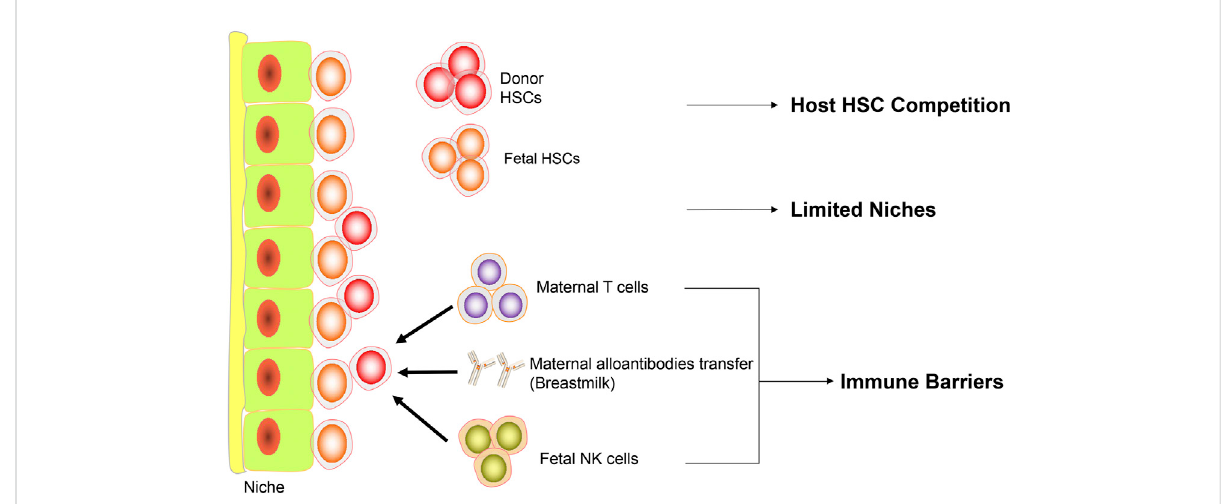
Barriers to IUHCT. Diagram representing the current barriers to IUHCT. Firstly, in normal recipients, the fetal HSCs compete with donor HSCs. Secondly, there are limited niches available in the fetal microenvironment. Thirdly, maternal T cells, maternal alloantibodies transferred through breastmilk and fetal NK cells consist of immune